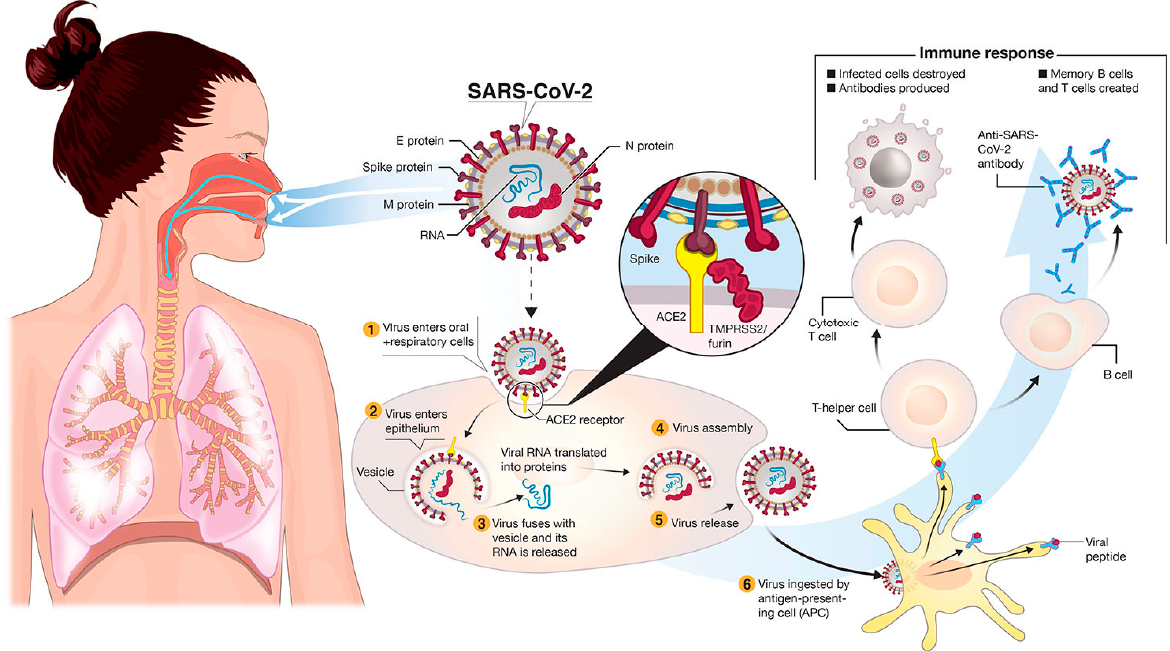
Figure 1. Transmission and life cycle of SARS-CoV-2 causing COVID-19. SARS-CoV-2 is transmitted via respiratory droplets of infected cases to oral and respiratory mucosal cells [6].